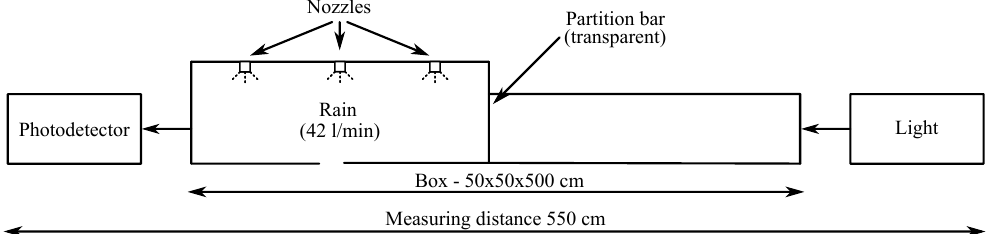
Figure 22. Octavia tail-light setup adjusted for scenario 3—Rain 42